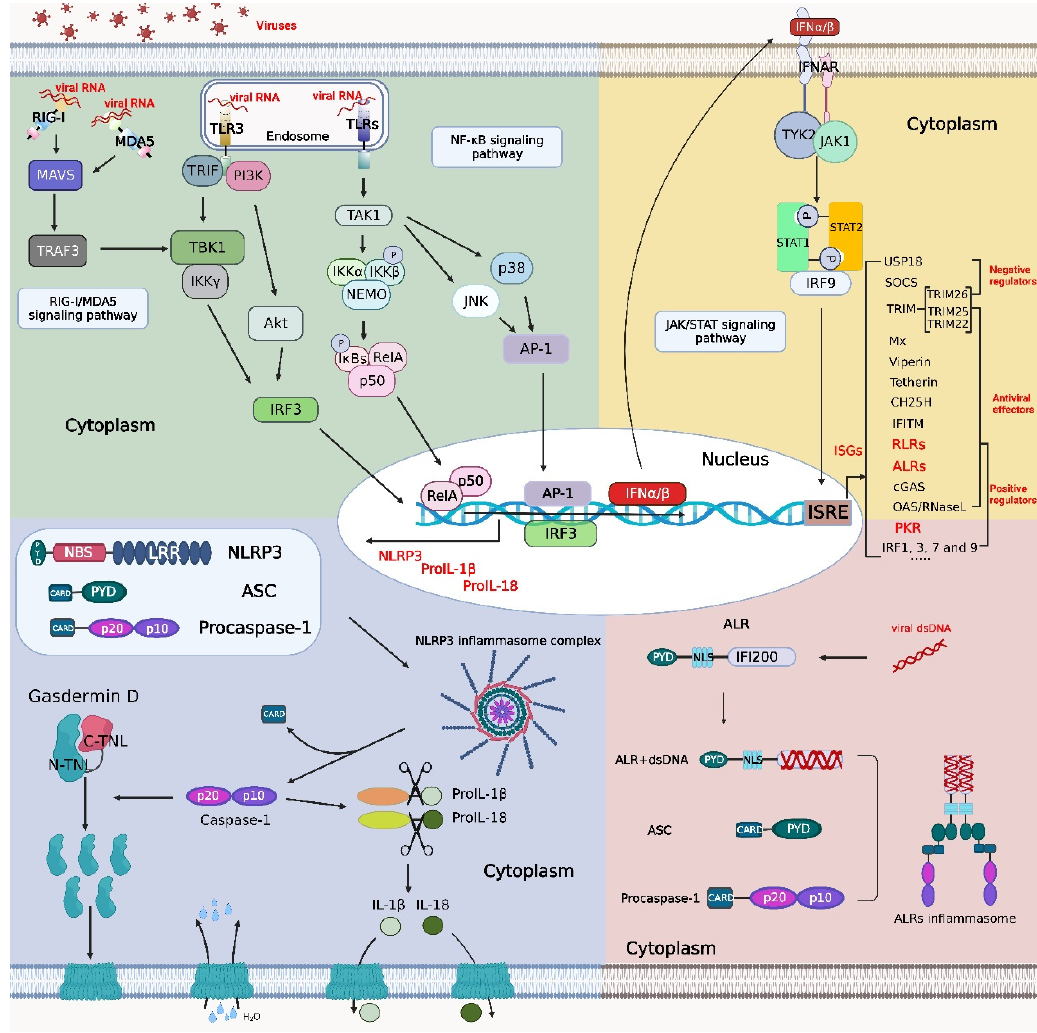
Figure 1. Crosstalk among the NF- κ B, inflammasome, and IFN signaling pathways. Viral RNA binds to retinoic acid-inducible gene-I (RIG-I)-like receptors (RLRs) and Toll-like receptors (TLRs) to